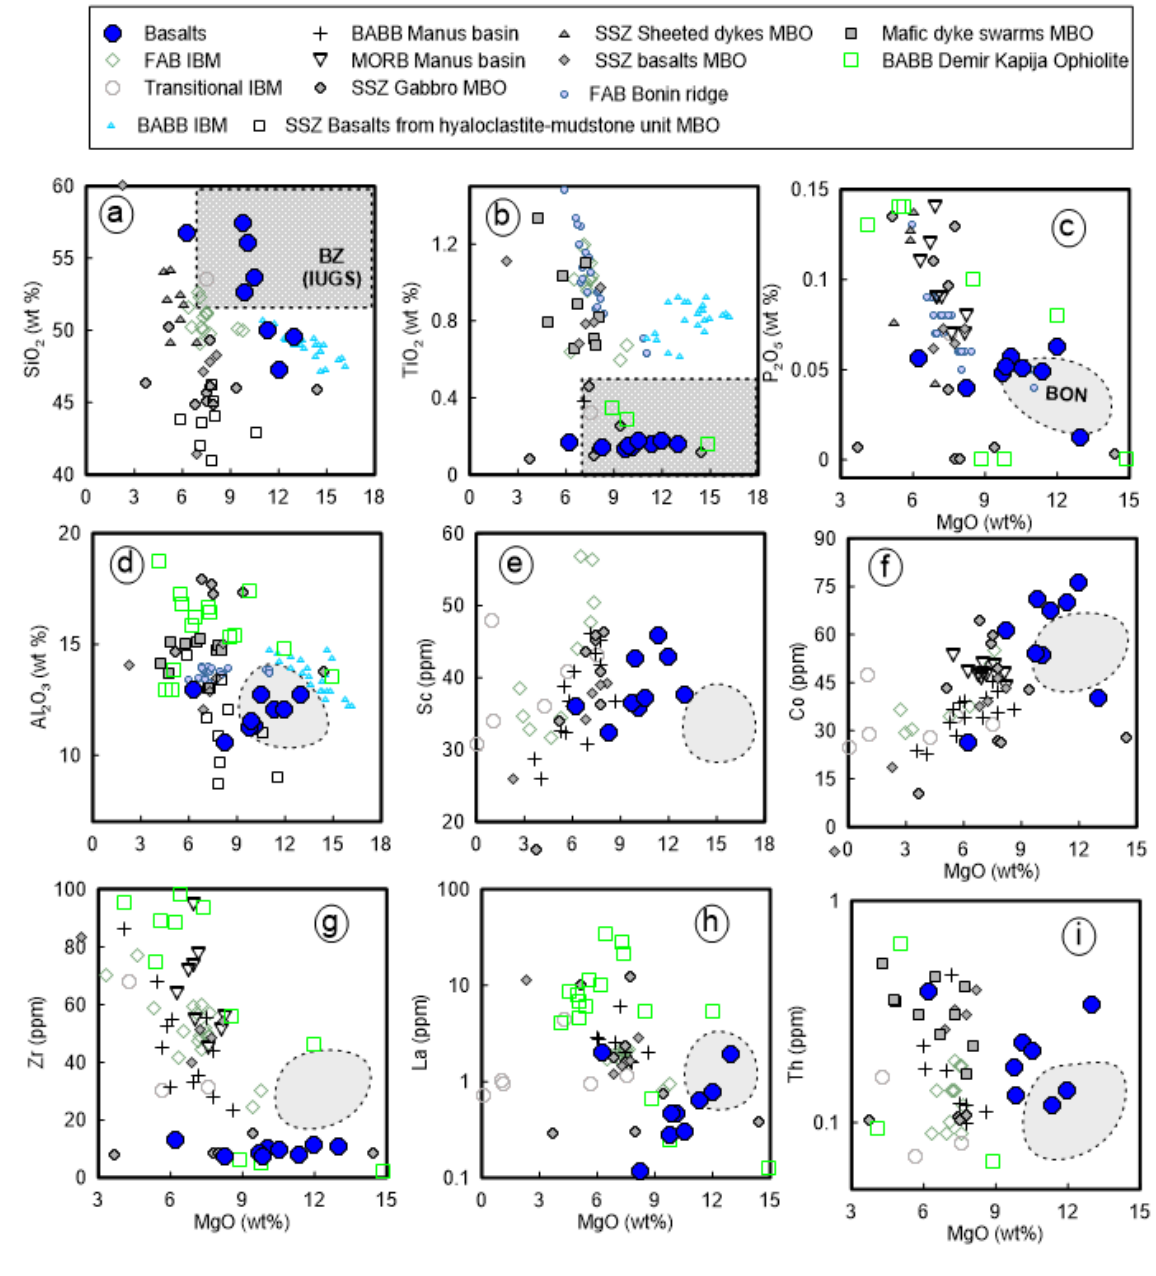
Figure 7. Harker diagrams of whole rock majors (wt%) and trace elements (ppm) against MgO (wt%) for the studied basalts of WOC. Field of boninite zone (BZ) International Union of Geological Association (IUGS) is from Le Bas [70]. Data of forearc basalts (FAB) Izu-Bonin-Mariana (IBM), boninites IBM (BON), and transitional basalts are from Reagan et al. [67] and Meffre et al. [74]. Data of back-arc basin basalt (BABB) Manus Basin and Mid-ocean ridge basalt (MORB) Manus Basin are from Beier et al. [75]. Data of suprasubduction zone rocks [4] from Muslim Bagh ophiolite (MBO), FAB from Bonin ridge [76], BABB from The Demir Kapija Ophiolite [62], and BABB from IBM [68] are shown for comparison.